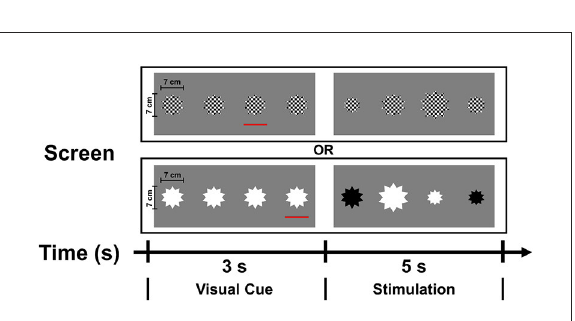
FIGURE2 The timing sequence of a single trial. Each trial consisted of the visual cue of 3s and the stimulation time of